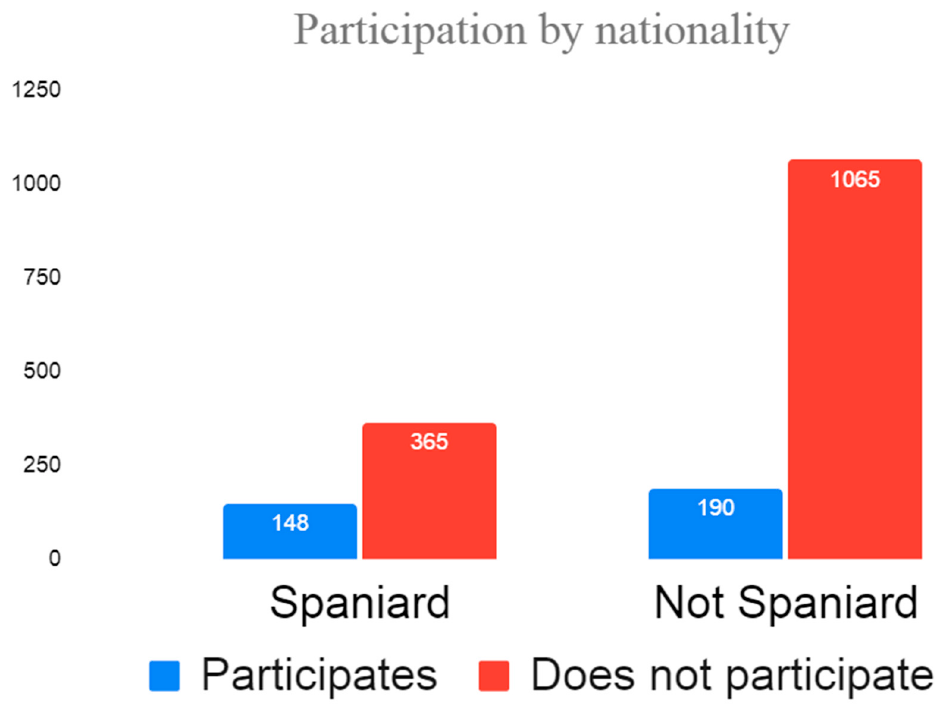
Figure 2. Participation distribution by nationality.